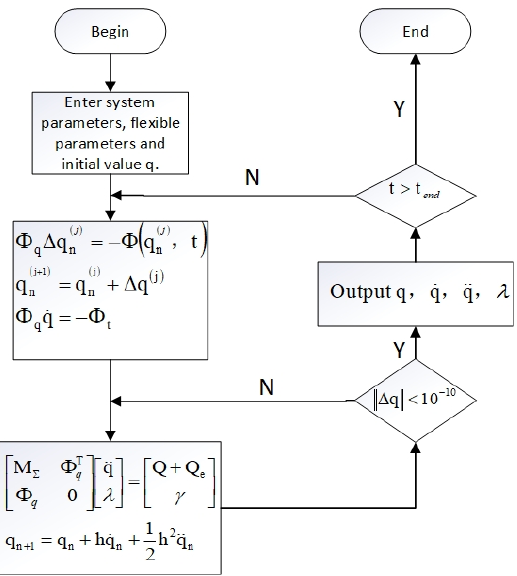
Figure 3. Flow chart of